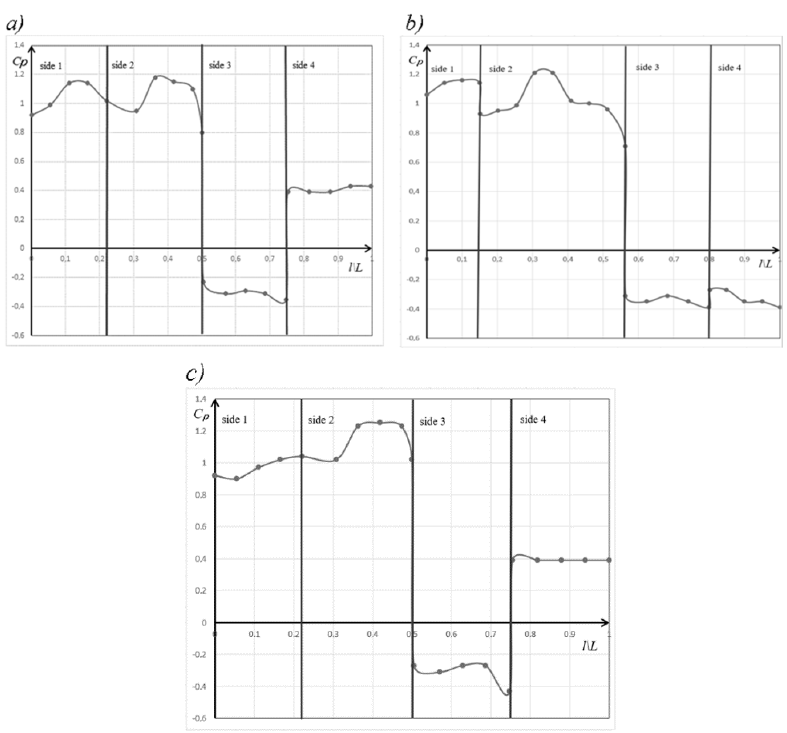
Figure 3. Dependences of the pressure coefficient Cp on the dimensionless coordinate l \ L: ( a ) for cutting А - А ; ( b ) for cutting В - В ; ( с ) for cutting С - С .